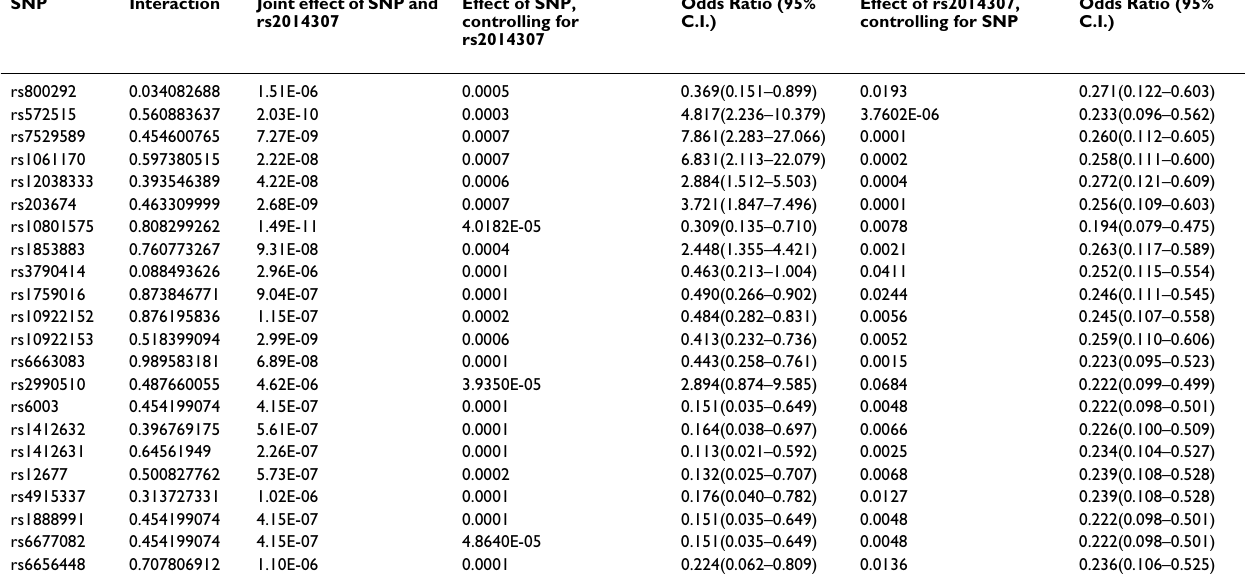
Table 3: Pairwise SNP Analysis SNP Interaction Joint effect of SNP and rs2014307